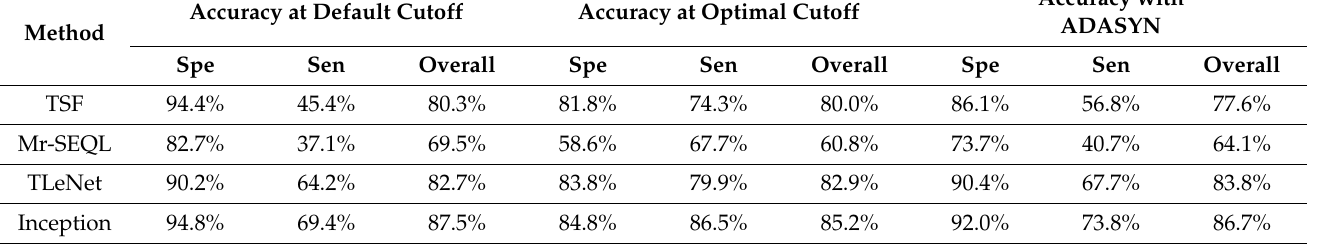
Table 2. Specificity (for NLOB), sensitivity (for LOB), and overall classification accuracy of the two-class models at default cutoff and optimal cutoff, as well as the results using the adaptive synthetic sampling approach (ADASYN). Spe indicates specificity, Sen indicates